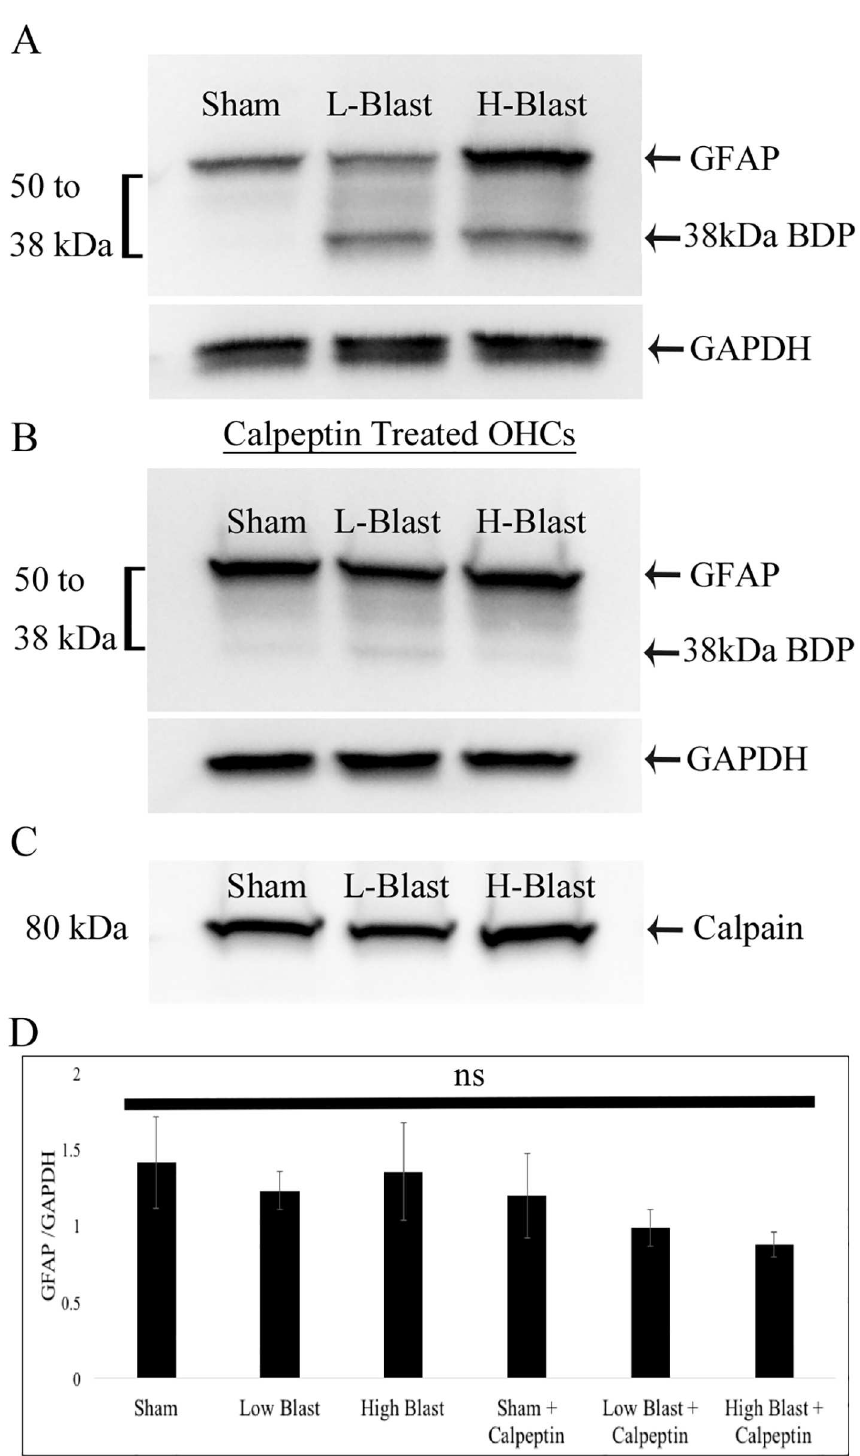
Fig 3. Calpain-mediated degradation of GFAP at 2 h following blast injury. Proteinswere isolatedfrom sham control (Sham), low-blast(L-Blast), and high-blast(H-Blast) OHCs at 2 h post-injuryand analyzedvia western blot for expressionof GFAP (A, B) or calpain(C). (A) The 38 kDa calpainassociatedGFAP-BDP was present in blast-injuredOHCs, but not in correspondingsham control OHCs. (B) Followinginhibitionof calpain via calpeptintreatment, this GFAP-BDP at 38 kDa was not observed. (C) Calpainexpressionin OHCs exposedto blast overpressure compared to sham controls was not changedat this time point. (D)